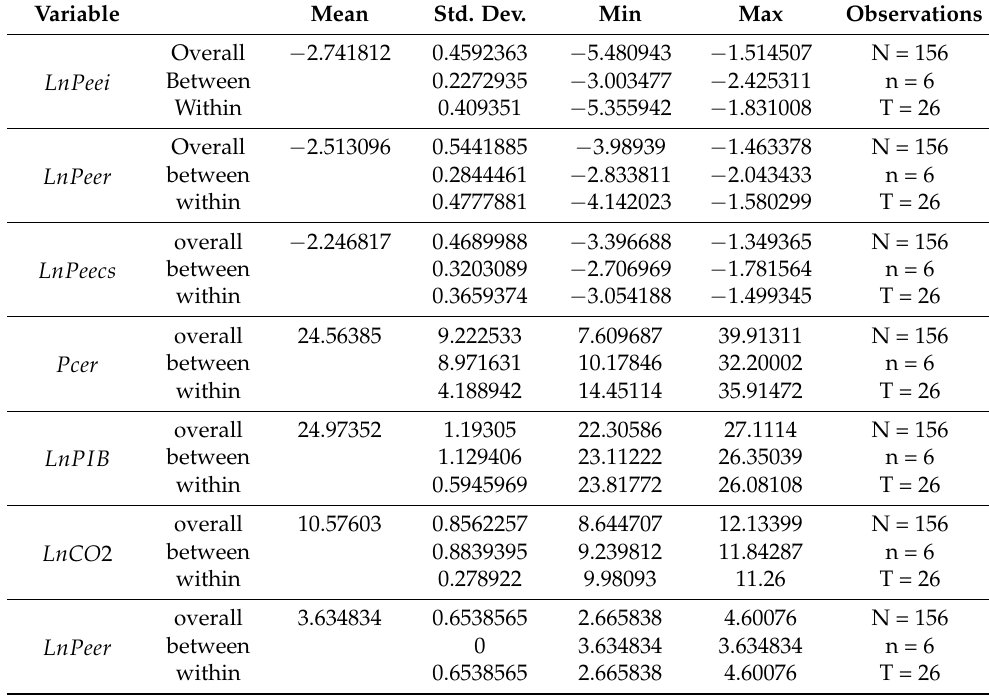
Table 2. Description of the main indicators of the variables.